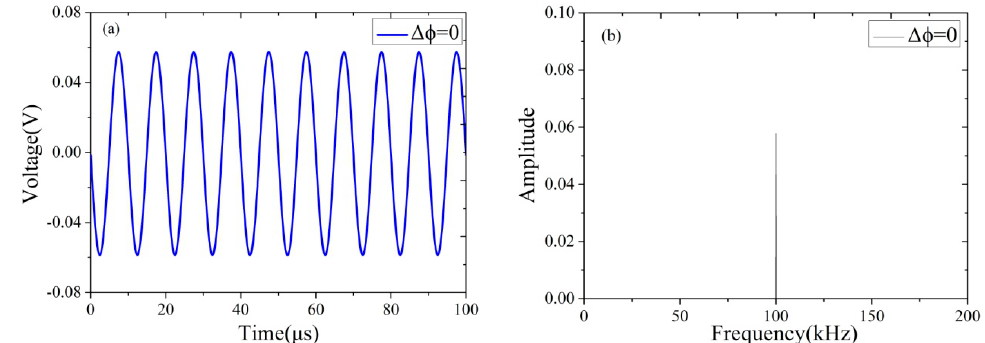
Figure 2. Ooutput voltage signal without phase modulation in the numerical simulation. ( a ) Output voltage waveform; ( b ) corresponding frequency spectrum.